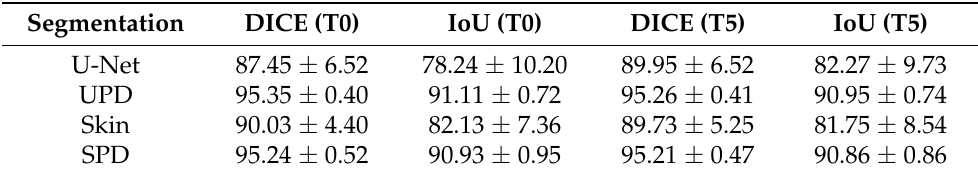
Table 3. DICE and IoU provided by the U-Net and Skin segmentation approaches as well as their refined prediction achieved considering the depth information. Values are expressed in percentage at each time point, T0 and